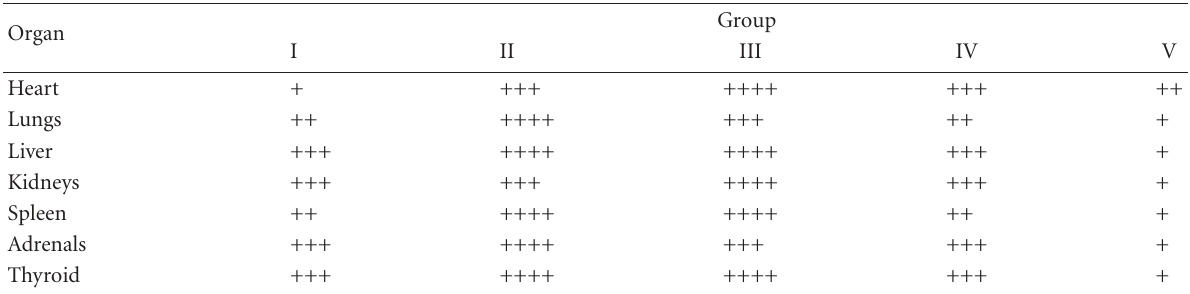
Table 6. Organ weights for each group. The model-based groups are defined by the probabilities response for the variables, here represented on a semiquantitative scale: “+ + ++” denotes the highest quartile of weight, while “+ + +,” “++,” and “+” denote the respectively lower quartiles.